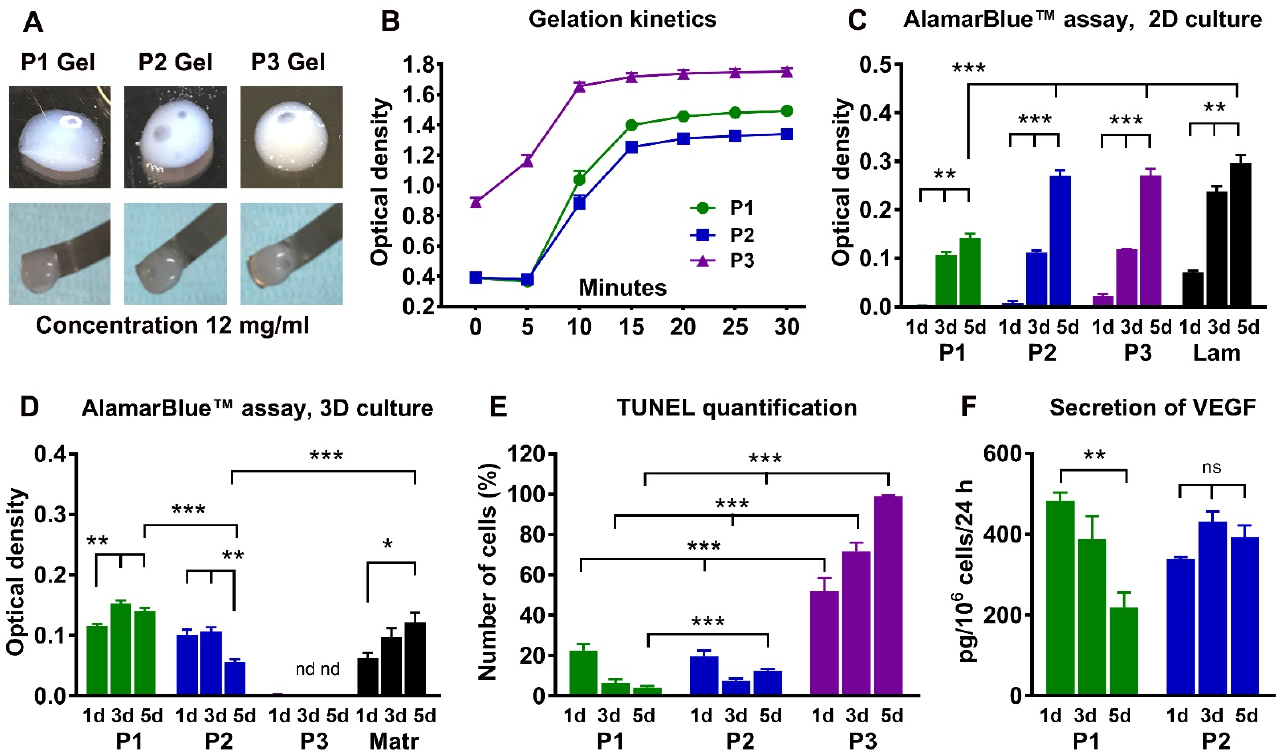
Figure 4. Characterization of the nerve-derived hydrogels. Images and histogram in ( A , B ) show appearance and handling of the 12 mg/mL P1, P2, and P3 hydrogels after solidification, and their gelation kinetics ( n = 5). Histograms in ( C , D ) demonstrate Schwann cell proliferation and viability at 1, 3, and 5 days in the wells coated with P1, P2, or P3 hydrogels (2D culture, n = 6), or following suspension of the cells into hydrogels (3D culture, n = 3). Laminin (Lam in C ) and Matrigel (Matr in D) are used as control substrates. Histograms in ( E , F ) show the proportion of TUNEL-positive Schwann cells in hydrogels ( n = 3) and production of growth factor VEGF ( n = 3) in 3D culture. Error bars show the S.E.M., nd, not detected. p -values are indicated as follows: * p ≤ 0.05, ** p ≤ 0.01 and *** p ≤ 0.001; ns, not significantly different. Scale bar, 25 µm.